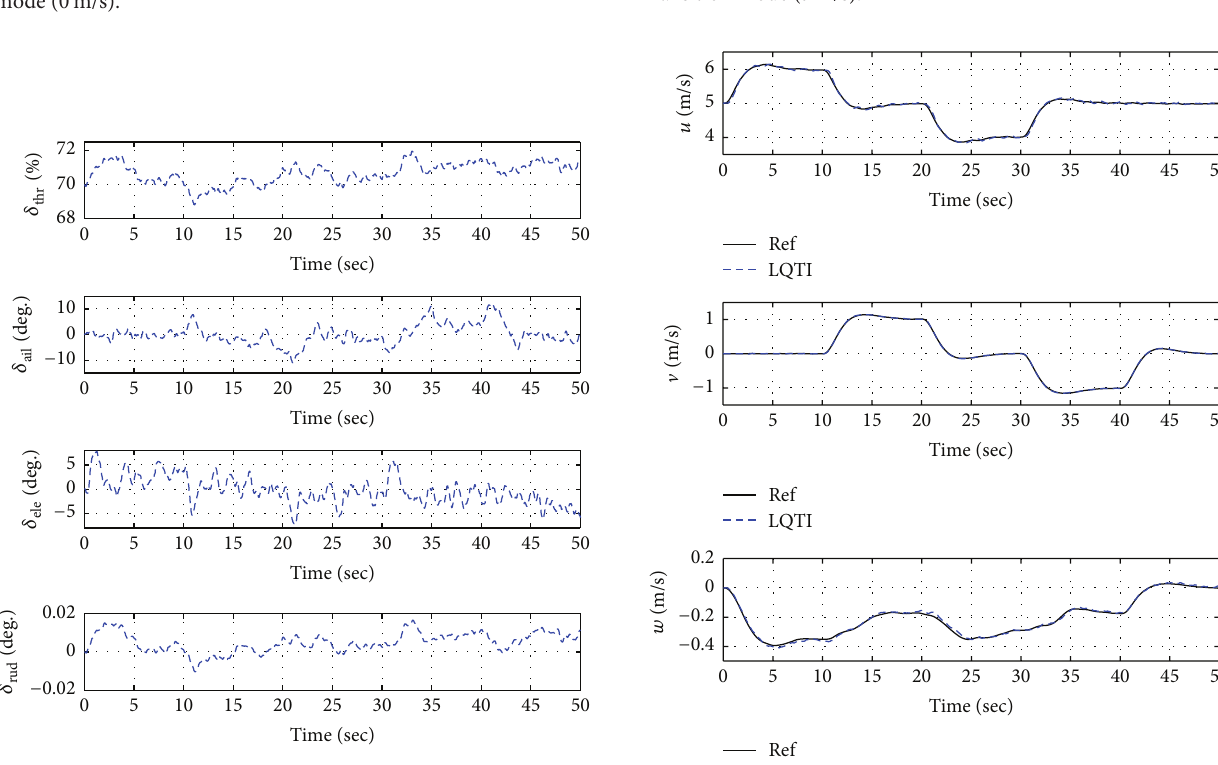
Figure 19: Time histories of position at transition mode (Case 2). Transition mode (5m/s).